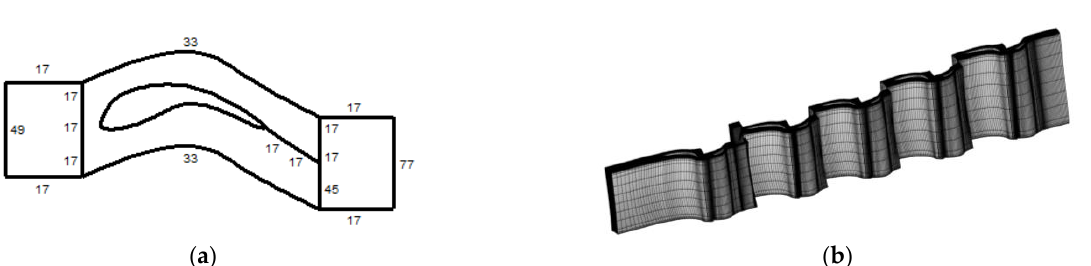
Figure 1. Model structure.